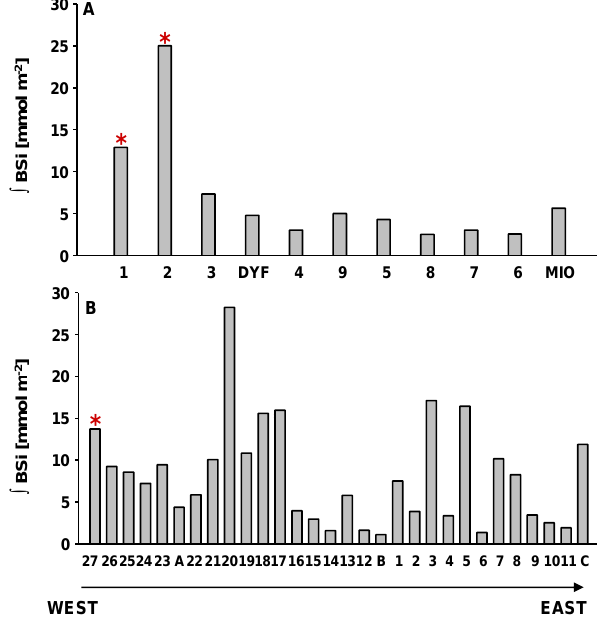
Fig. 10. (A) Distribution of particulate organic carbon (POC) (µmolL − 1 ) , with BSi concentrations (µmolL − 1 ) isopleths as over- lays in white and (B) BSi:POC ratios (mol:mol) along the BOUM cruise (summer 2008).